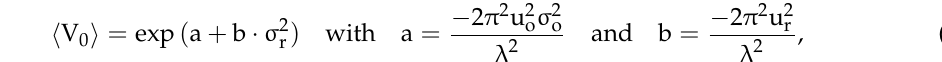
I : extrema of intensity in a fringe interferogram generated by two smooth surfaces. norm,max,min